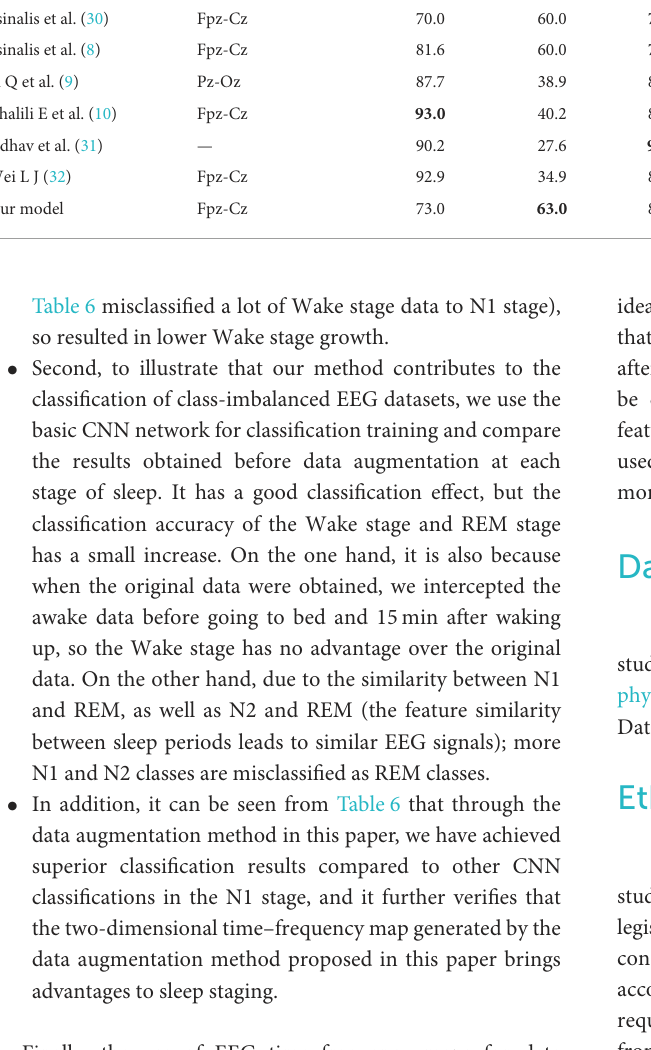
TABLE 6 Comparison of classification results after data augmentation using the RDB-DCGAN model with other classification results.